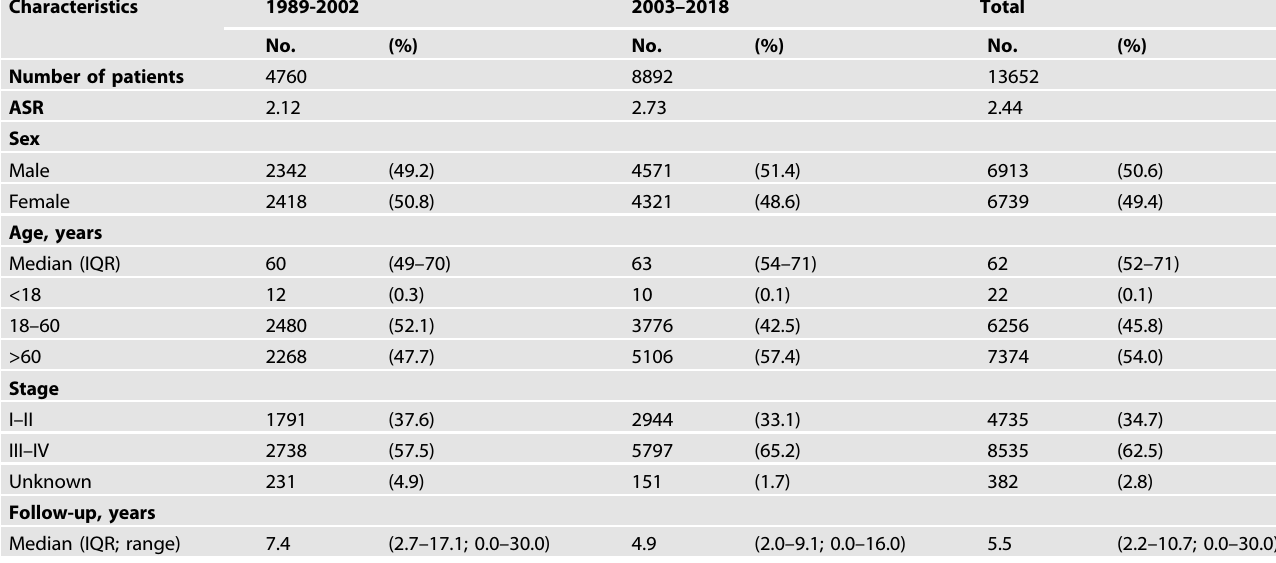
Table 1. Patient characteristics. Abbreviations: ASR, age-standardized incidence rate; IQR, interquartile range.